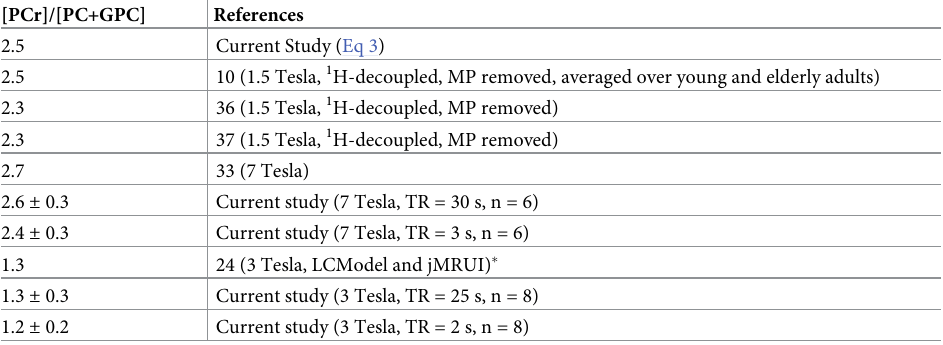
Table 5. Comparison of [PCr]/[PC+GPC]